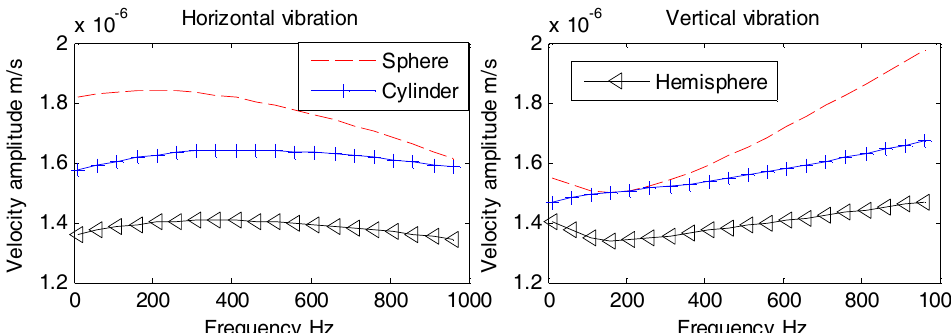
Figure 18. Vibration velocity amplitudes of the OBSs with different shapes under incident angle of 60 ◦ .